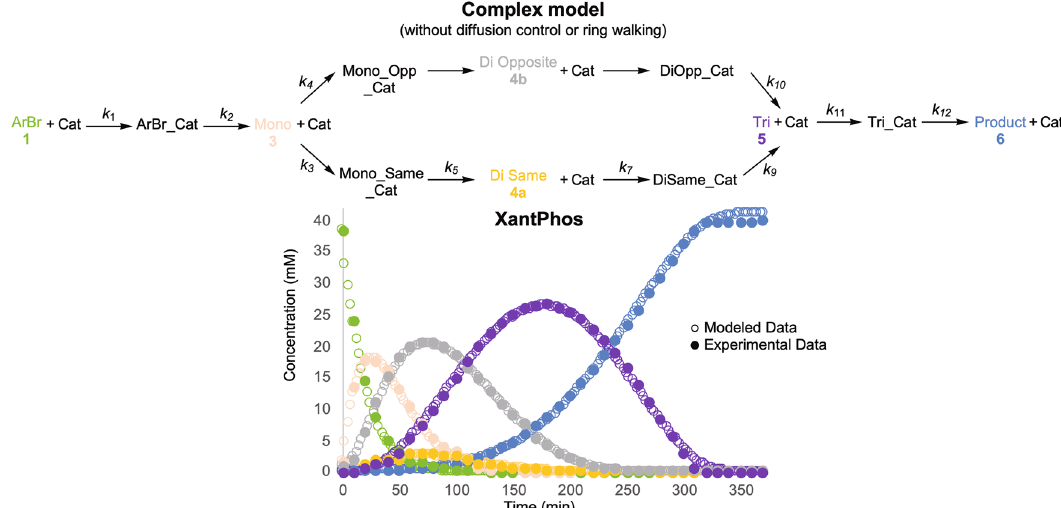
Fig. 6 COPASI model of XantPhos Pd G4. Overlay of the experimental and modeled time course data of the standard conditions reaction using XantPhos Pd G4 as the precatalyst.